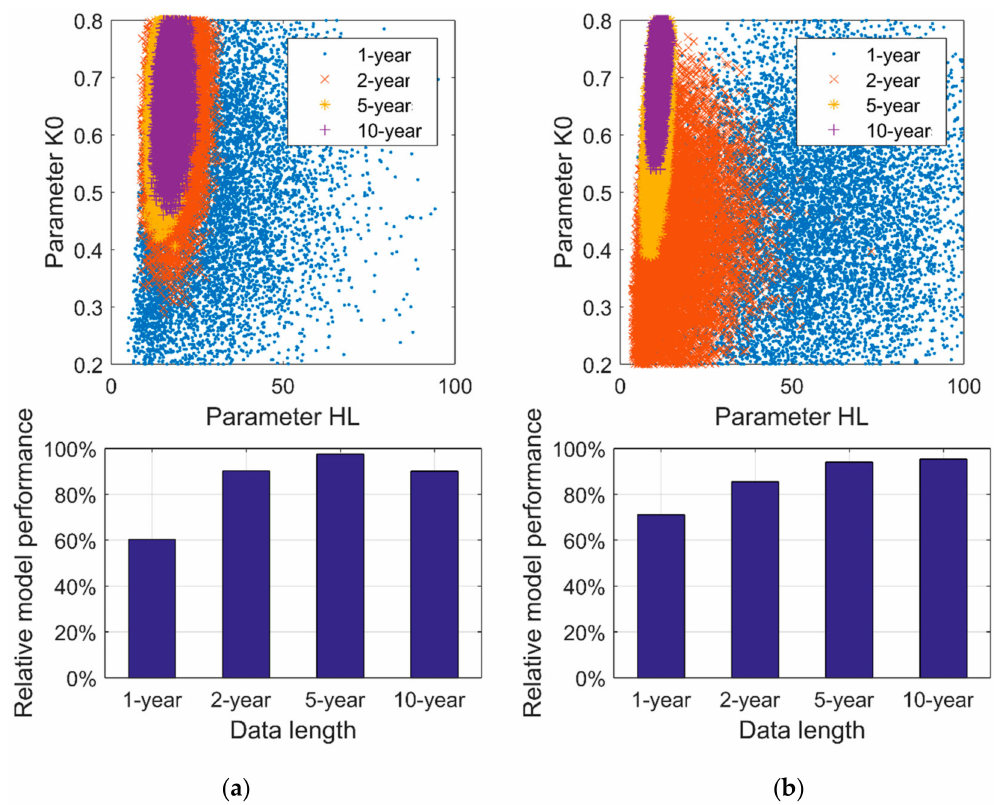
Figure 8. Distribution of model parameter HL and K0 that calibrated based on (upper) di ff erent lengths of data and the (lower) corresponding validation performance. ( a ) Catchment 01611500; ( b ) catchment